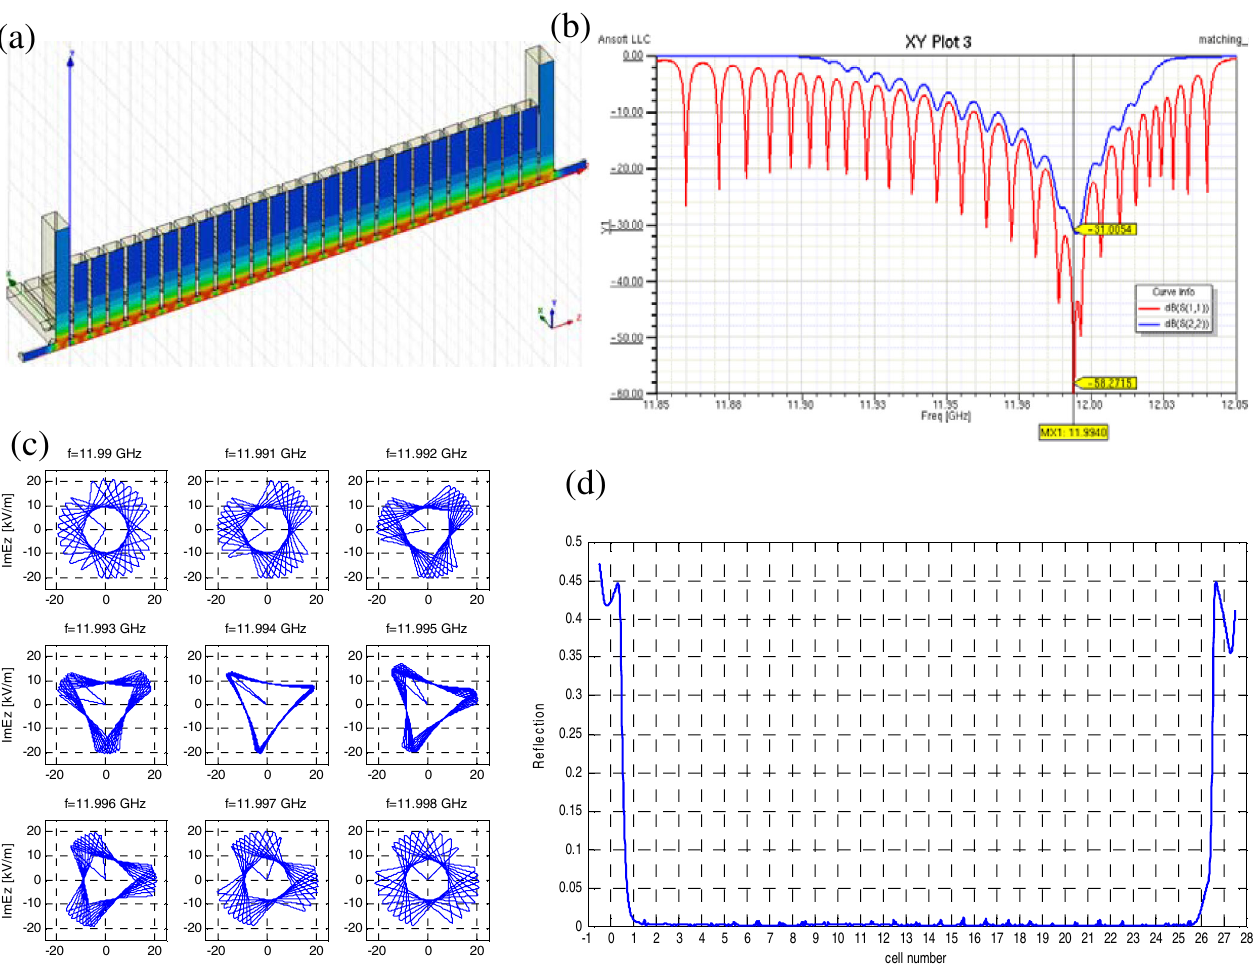
FIG. 2. The HFSS simulation of the full CLIC accelerating structure. Electric field profile (a), input ( S 11 , red curve) and output ( S 22 , blue curve) couplers matching (b), phase advance per cell versus frequency (c), and internal reflections (standing wave ratio) in the structure (d) are shown. The phase advance per cell is equal to 120 (cid:7) and both couplers are matched better than (cid:3) 30 dB level at operating frequency of 11.994